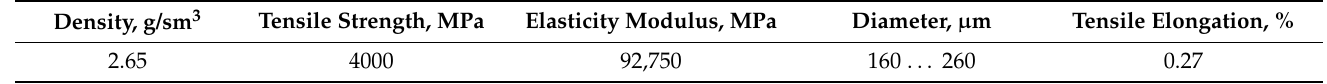
Table 4. Main characteristics of the coarse basalt fiber.